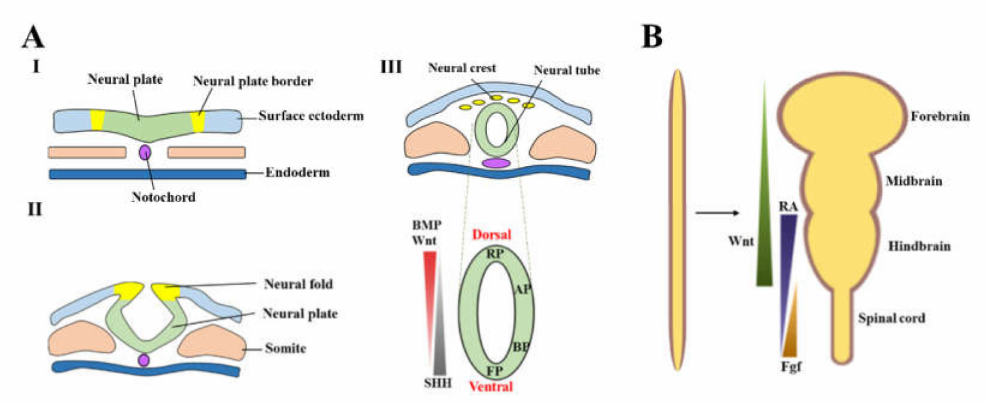
Figure 2. The schematic of the neural patterning principle: ( A ) Development of the neural tube (I-III) and the signaling governs the neural tube (which will develop into midbrain) at the D-V axis (III, bottom) and ( B ) the principle of neural development guided by the gradient signaling along A-P axis. Wnt regulates the development of the forebrain, midbrain, and hindbrain gradients of RA and Fgf involved in the segmentation of hindbrain and the spinal